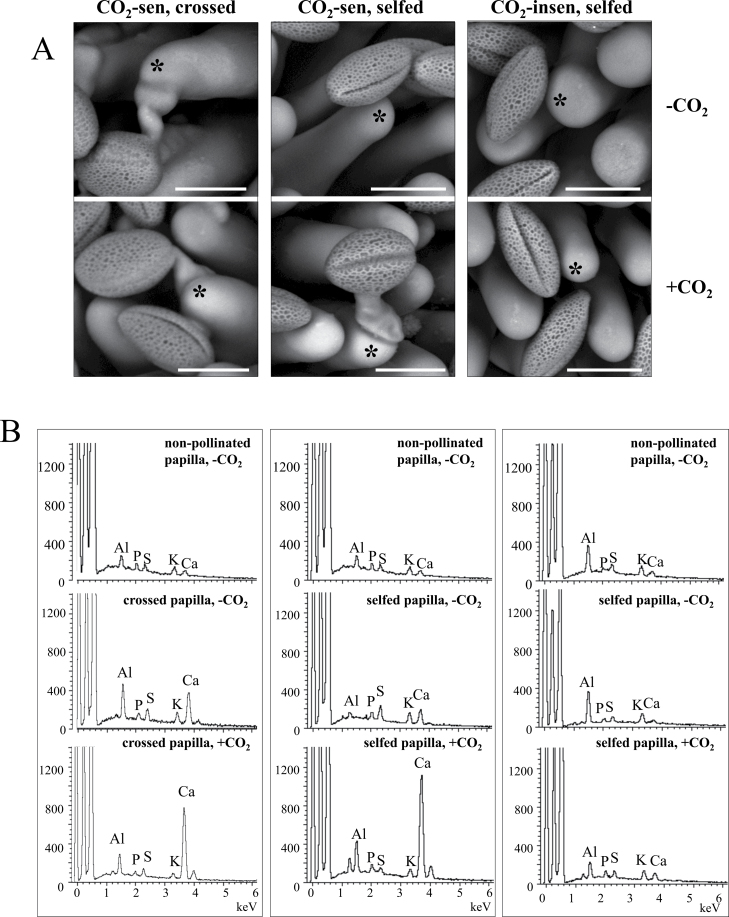
Electron micrographs and X-ray microanalysis of B. rapa. (A) Cryo-scanning electron micrographs of pollinated papilla cells were taken 1.5h after pollination. Representative examples of the cross-pollinated (left column) and self-pollinated (middle column) CO2-sensitive line, and the self-pollinated (right column) CO2-insensitive line are shown. Without CO2 treatment (upper panels), only cross-pollen is accepted, and self-pollen grains maintain a spheroid shape without swelling in both lines. With 4.5% CO2 gas treatment (lower panels), pollen grains swell and germinate in the CO2-sensitive line (lower middle) but not in the CO2-insensitive line (lower right). Bar=25 μm. (B) Representative examples of energy-dispersive X-ray spectra of non-pollinated and pollinated papilla cell surfaces. Scanning positions for X-ray analyses are indicated by asterisks in (A). The emissions of Al-Kα, P-Kα, S-Kα, K-Kα, and Ca-Kα were detected at the papilla cell surfaces, and the intensity of Ca emission was increased after cross-pollination (left column). The increase of Ca emission was also observed after self-pollination with 4.5% CO2 gas treatment in the CO2-sensitive line (middle column) but not in the CO2-insensitive line (right column). These spectrum patterns are reproducible in three individual experiment sets. The emission of Al-Kα is mostly derived from the stub that held the samples.